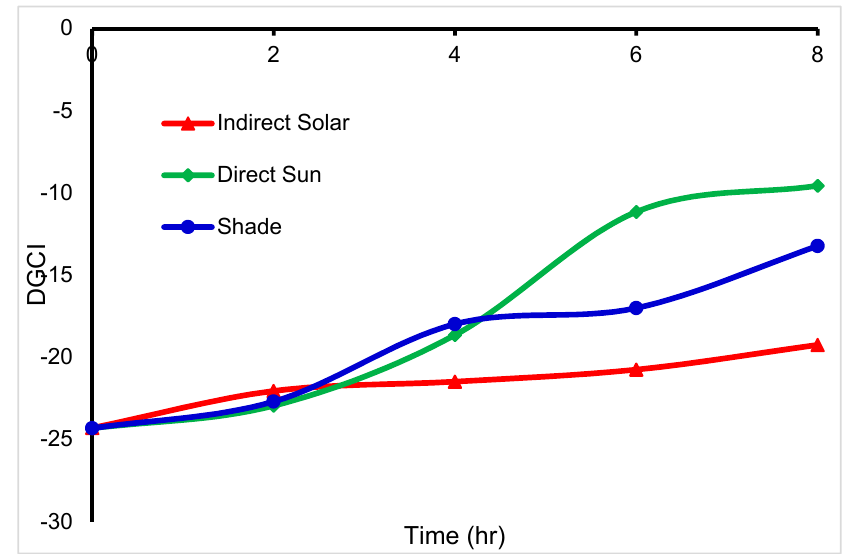
Figure 7. Comparison of Basil color parameters by drying method in summer season: (( a ) L*: Light ‐ ness, ( b ) a*: (+) redness/( − ) greenness, ( c ) b*: (+) yellowness/( − ) blueness, ( d ) Chroma, ( e ) Hue, and ( f ) color difference) degradation during indirect solar ‐ drying ( n = 3).